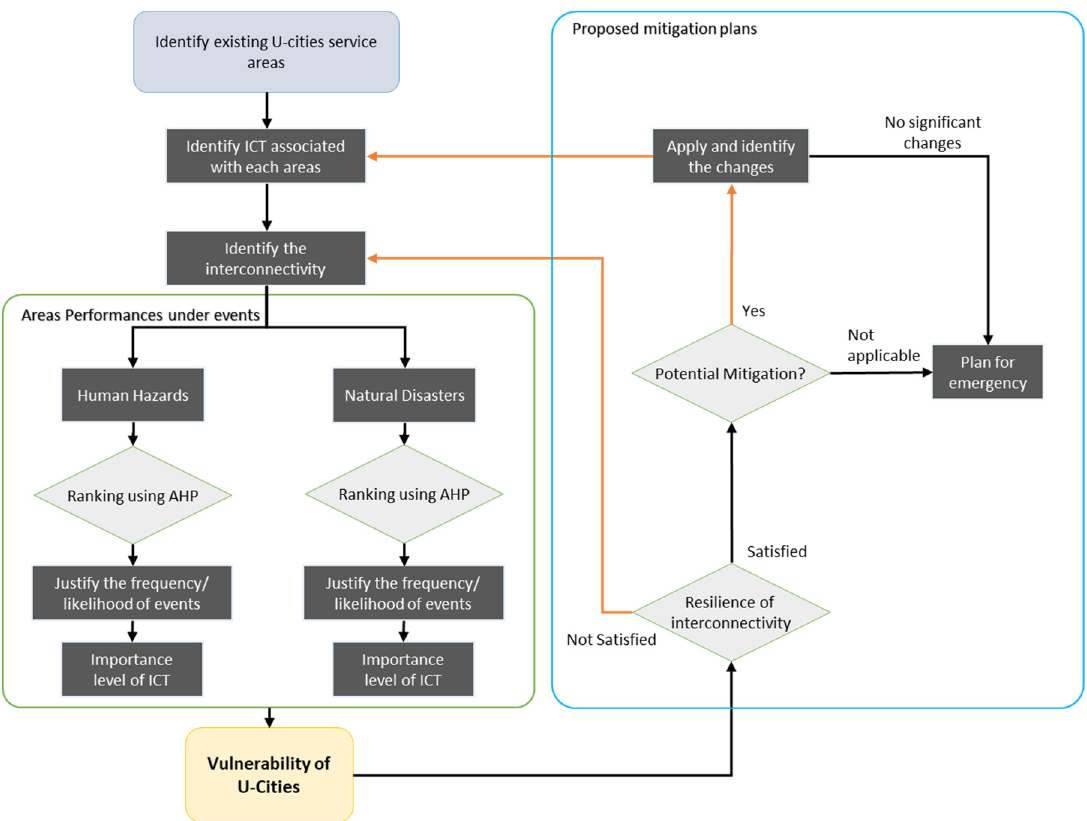
Figure 4. Schematic representation of vulnerability analysis and a possible plan of mitigation Interconnectivity of areas.